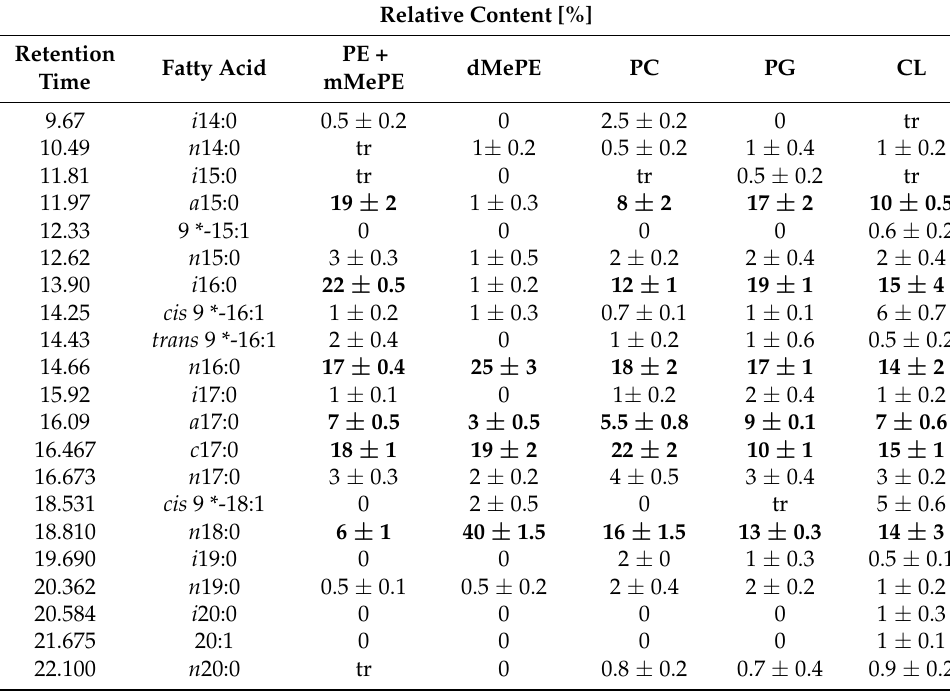
Table 1. Fatty acid composition of individual classes of L. gormanii phospholipids identified by FAME analysis via GC/MS. Fatty acids were liberated by saponification (0.8 M NaOH/50% methanol, 1